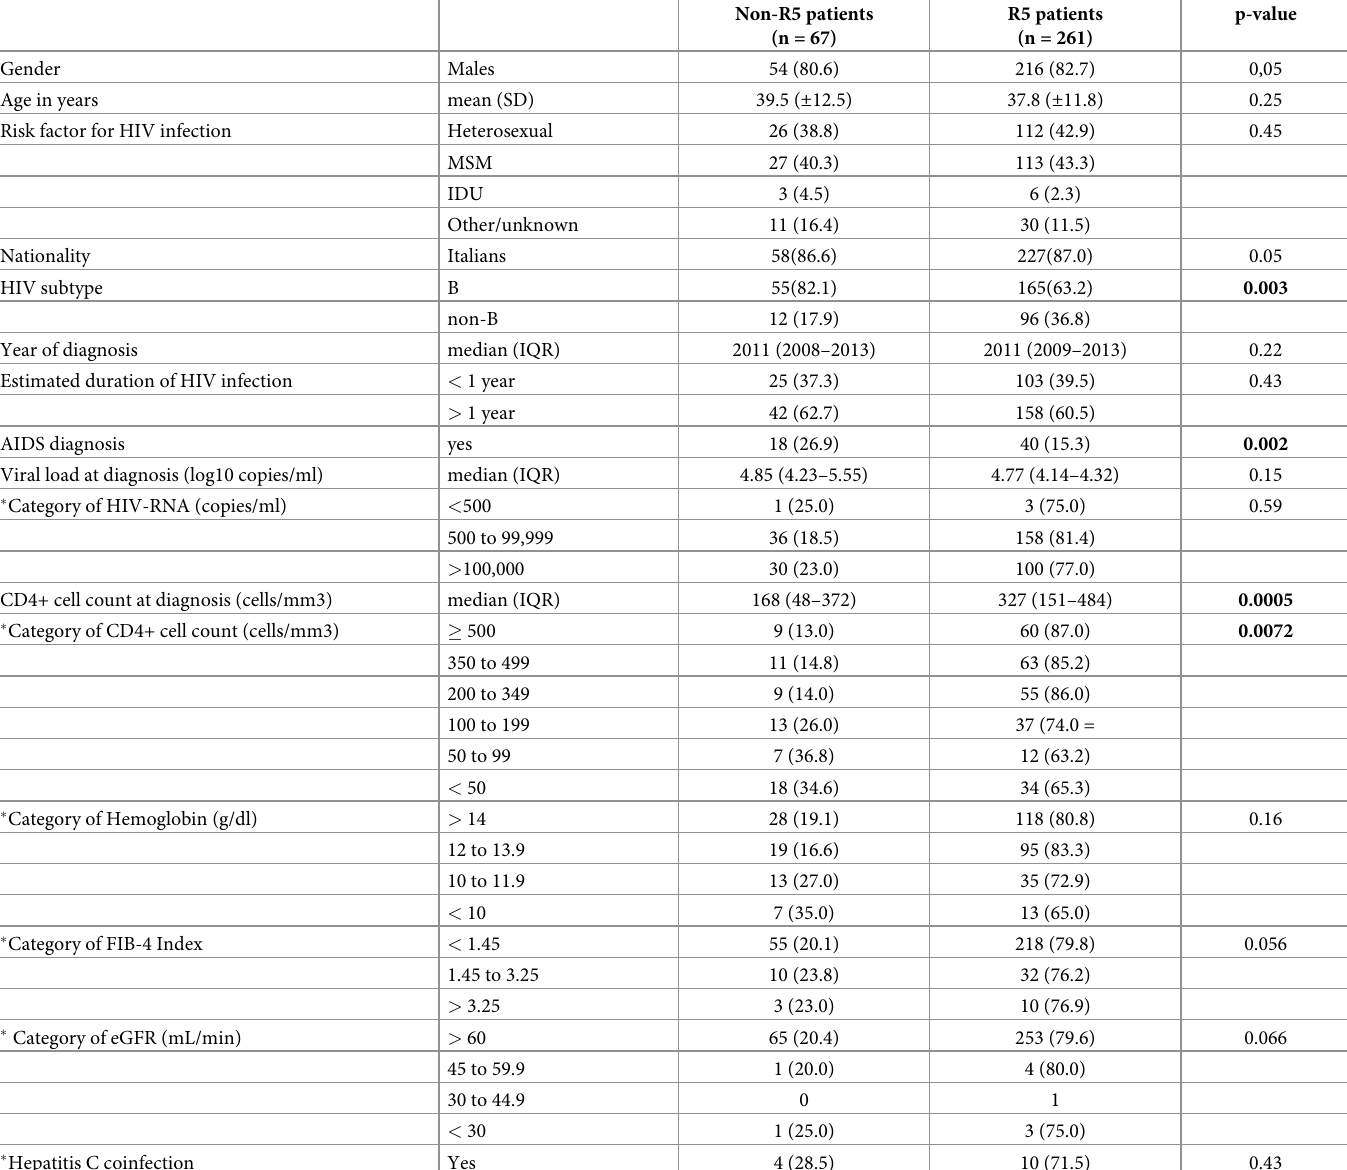
Table 1. Baseline characteristics of patients according to the coreceptor tropism of